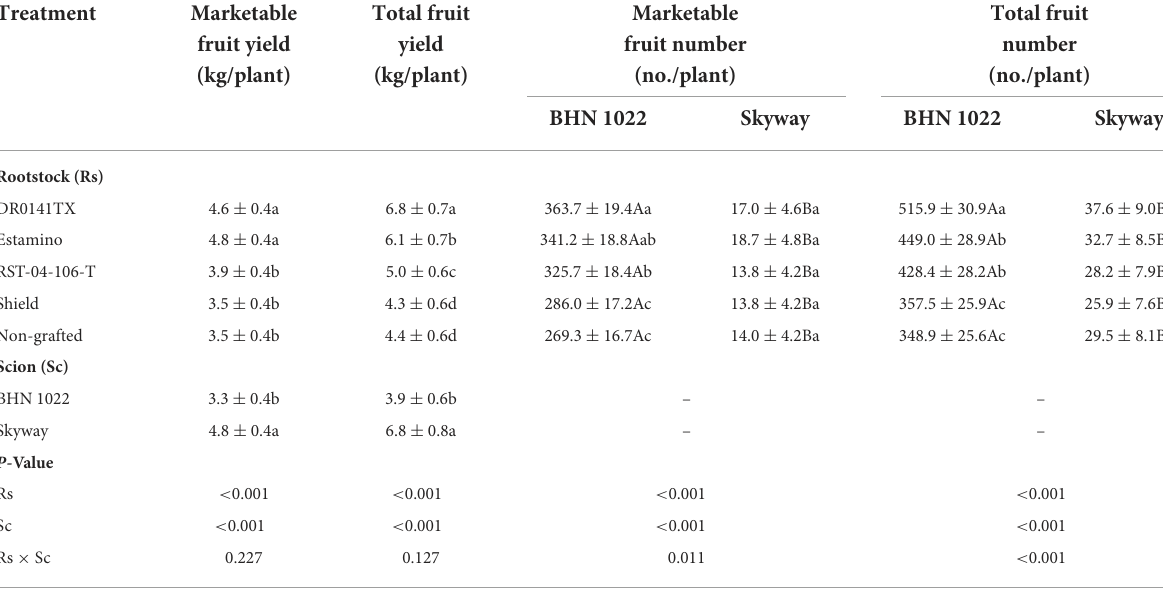
Total fruit number (no./plant)